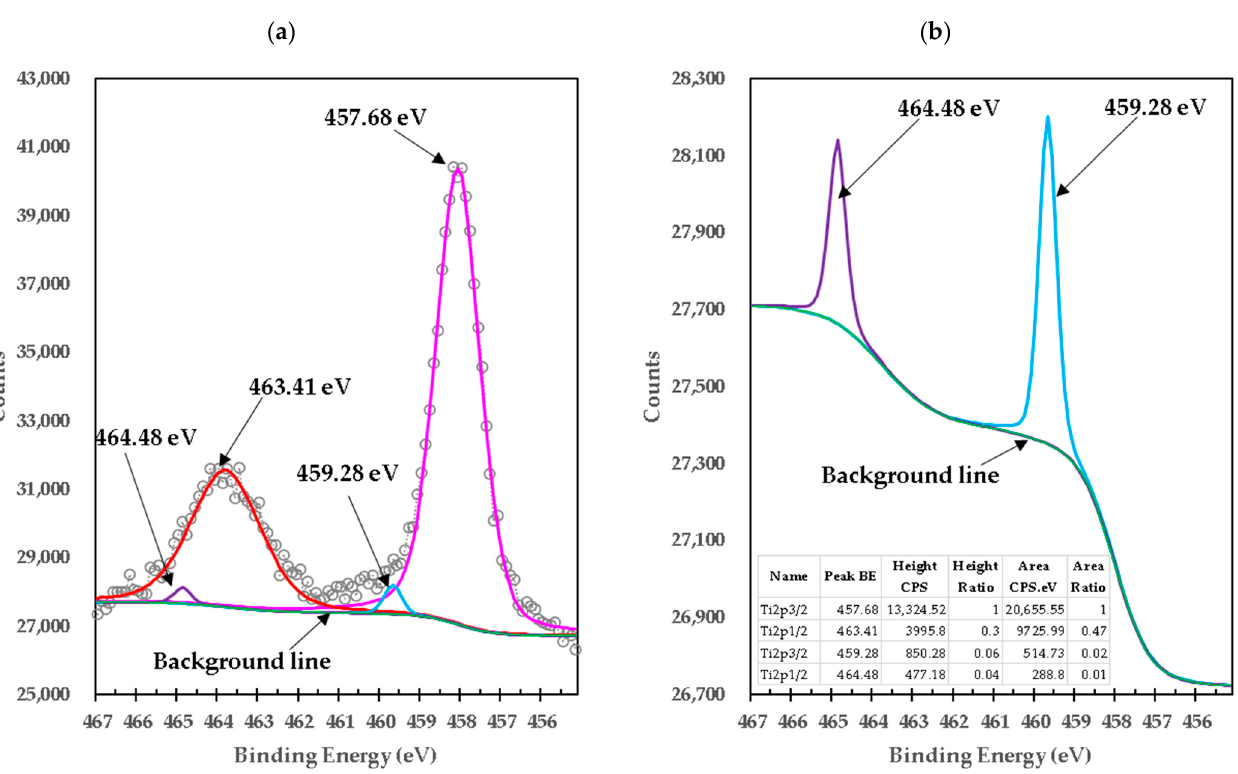
Figure 5. ( a ) XPS high-resolution spectra of Ti2p from TiO 2 mixed with brucite and calcined at 1100 °C for 1 h; ( b ) details for sample M1.